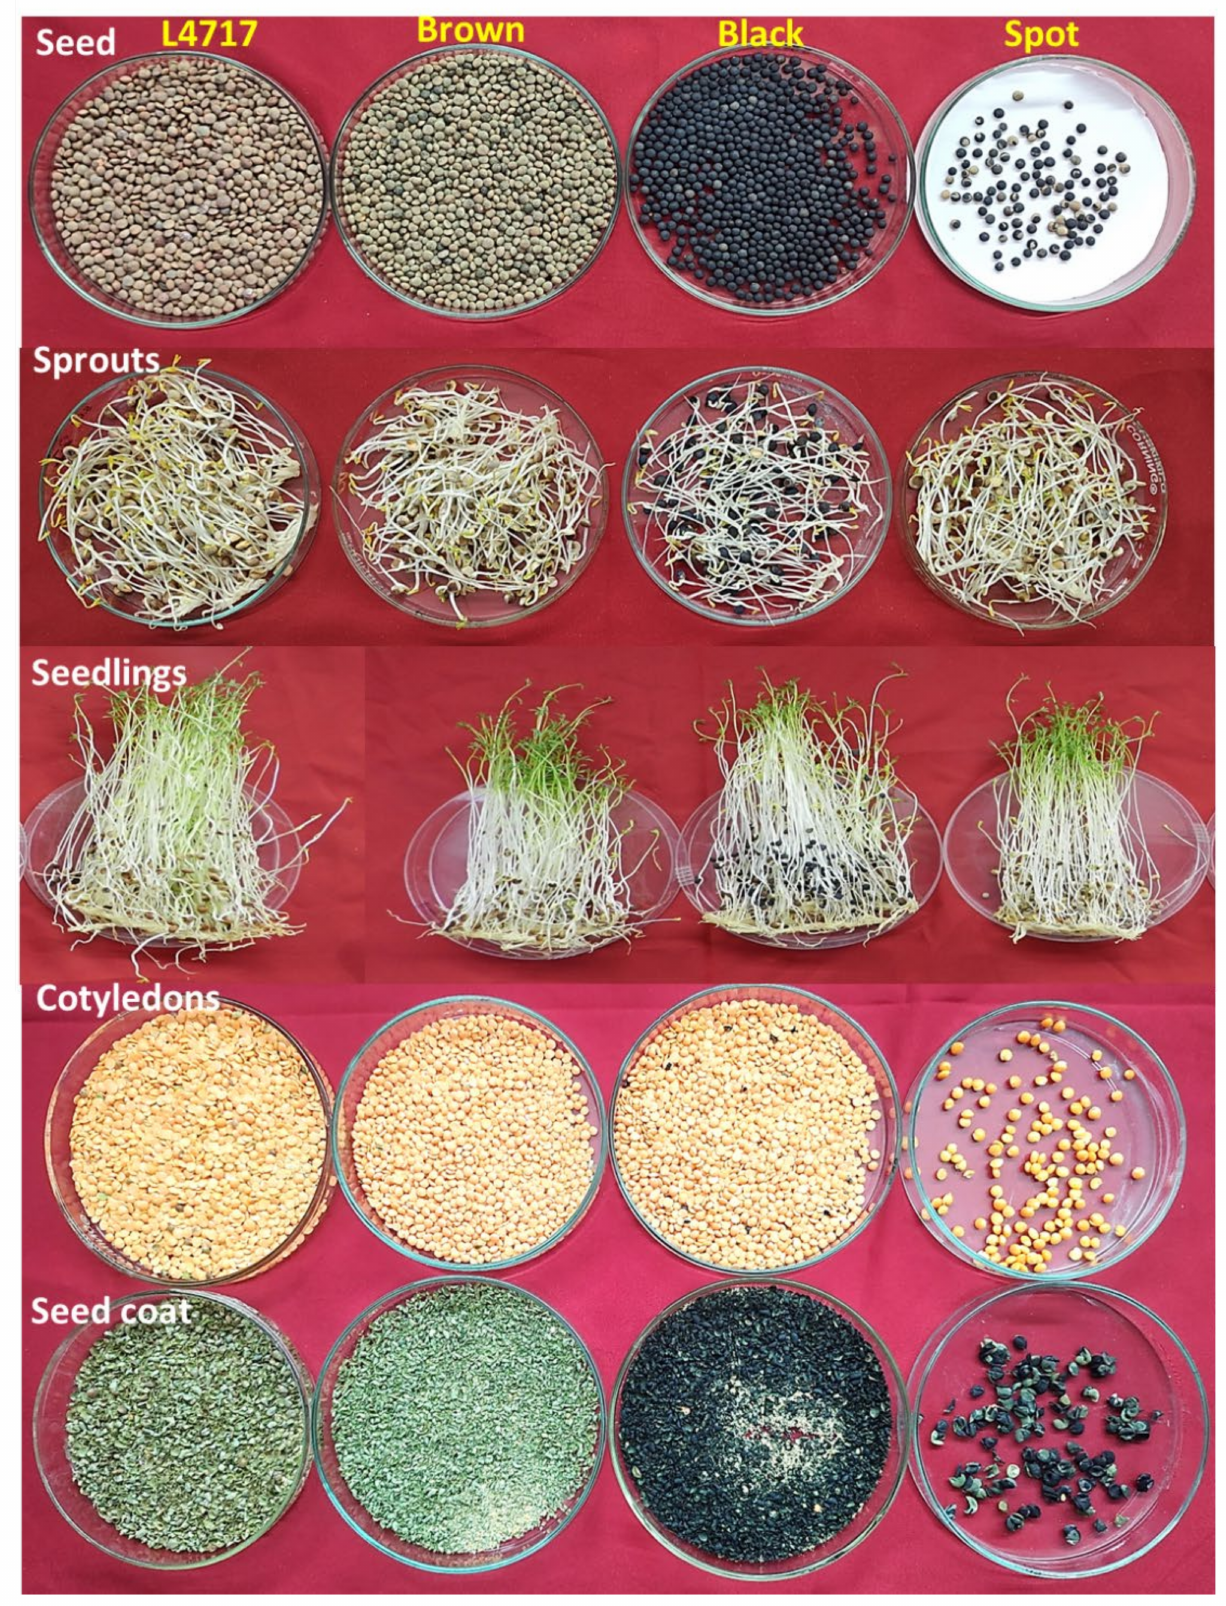
Figure 1. Phenotypic details of seeds, sprouts, seedlings, cotyledons, and seed coats of the genotypes L4717 and L4717-NM (brown, black, and spotted seed-coat